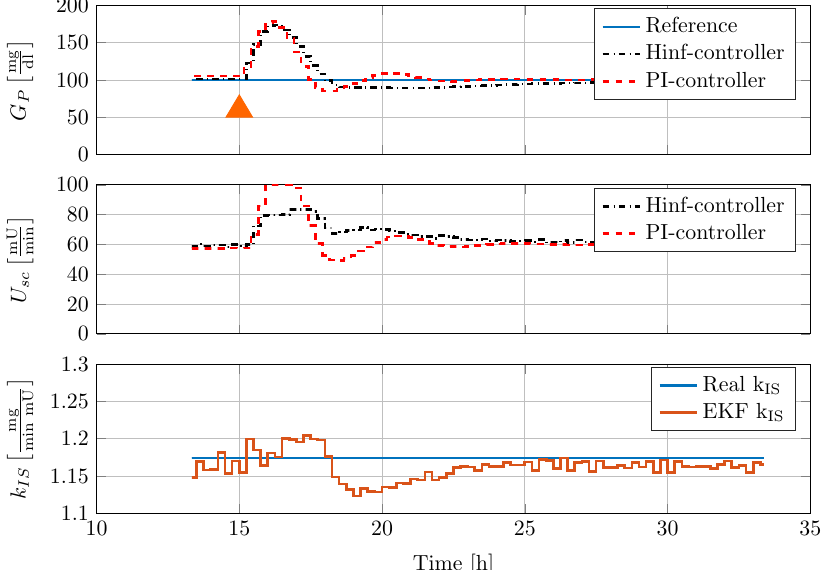
Figure 10. Comparison of controller disturbance rejection test with nonlinear minipig model #4. In this figure, 50 mg CHO are given to the minipig at 15 h, indicated by an orange triangle. Orally uptaken glucose is applied to the model over the course of 1 min simulation